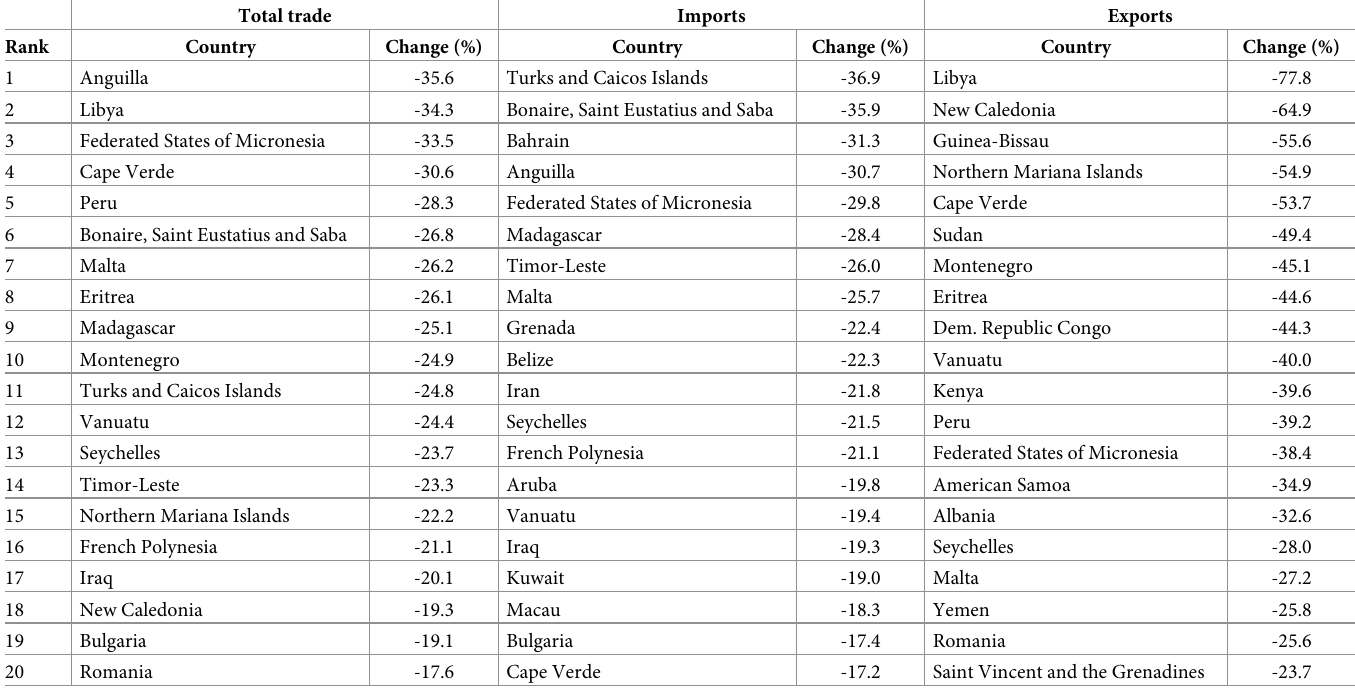
Table 2. Largest relative trade losses on a